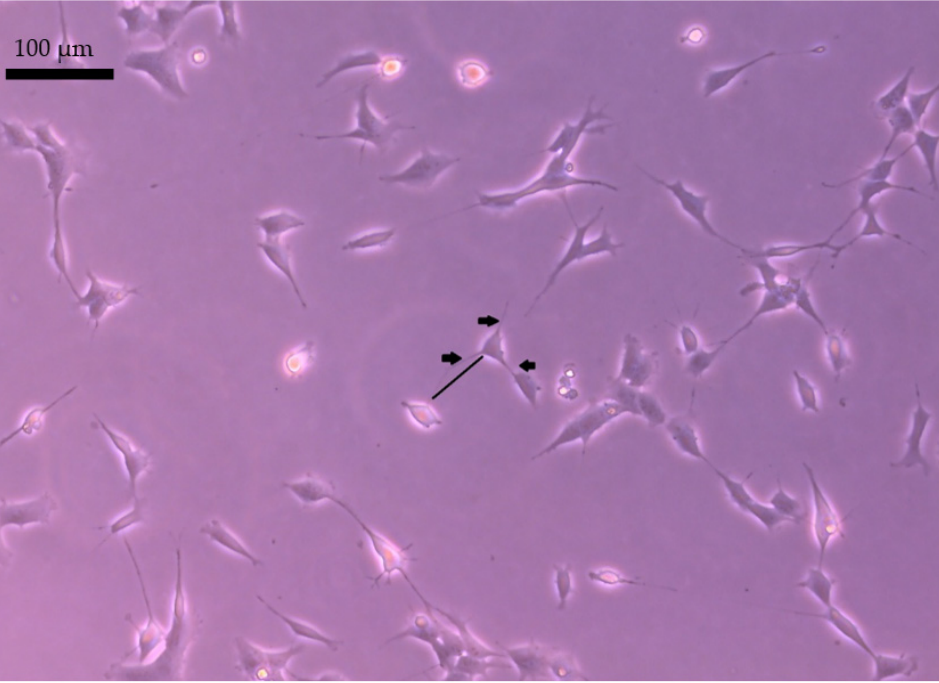
Figure 9. Density and lengths of neurites measurement. The length of neurites is marked with a black line, while the number is marked with arrows.